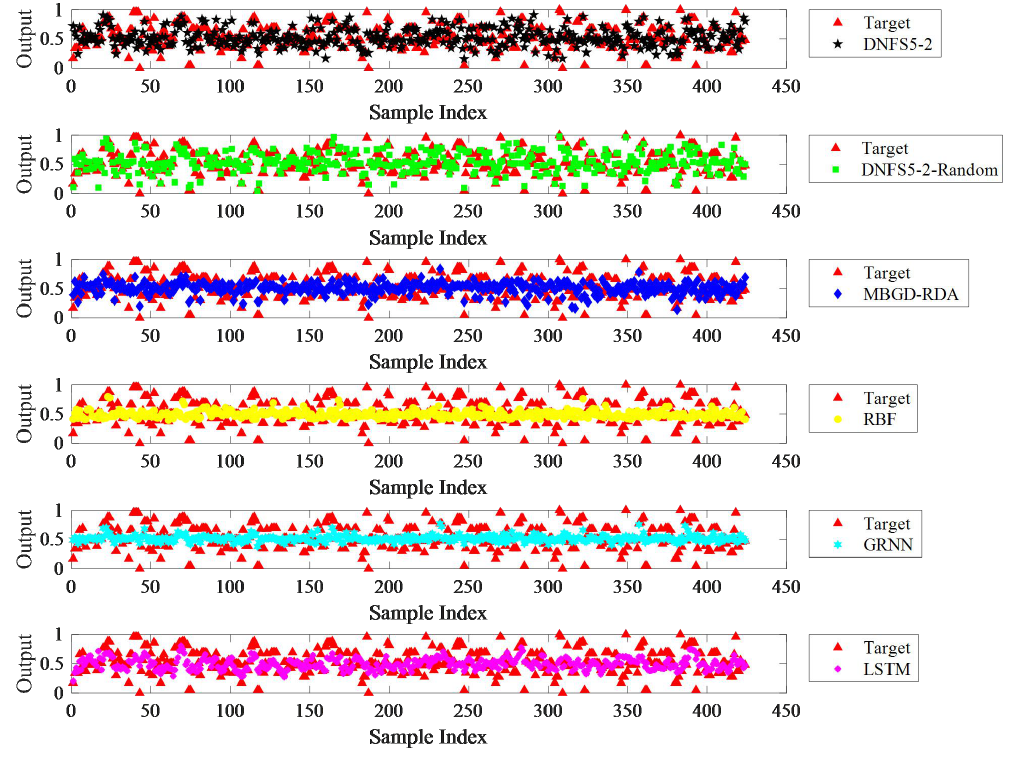
Figure 9. Prediction charts of different algorithms on Test Dataset No. 4.